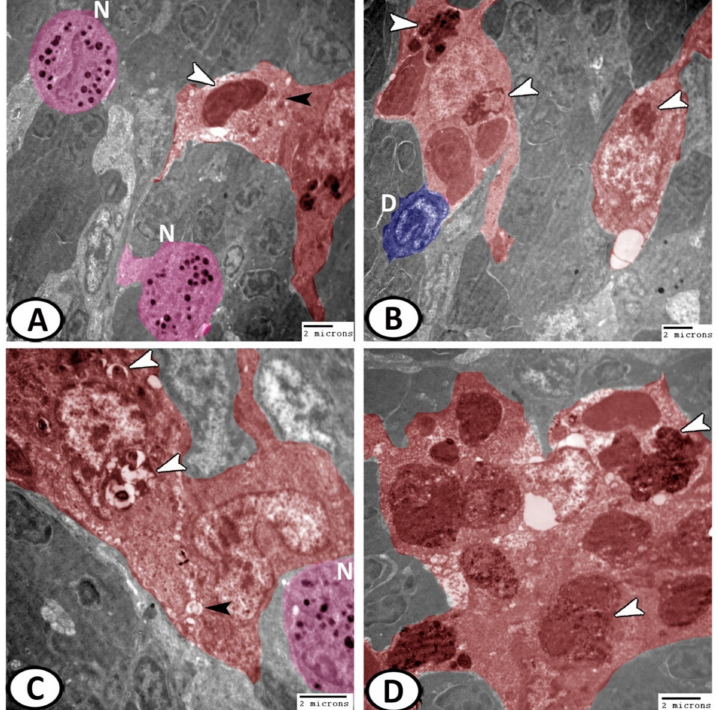
Figure 11. Digital colored TEM of the macrophages in the spleen. ( A , B ) Macrophages (red) dis- played long pseudopodia and their cytoplasm contained many lysosomes (black arrowheads) and other phagocytosed materials (white arrowheads). They were usually associated with dendritic cells (blue, D) and neutrophils (pink, N). ( C ) The active phagocytosing macrophages (red) were characterized by the kidney-shaped nucleus, vacuoles (black arrowheads), and phagocytosed ma- terials (white arrowheads). Note the presence of neutrophils (pink, N). ( D ) They were merged into spherical structures known as melanomacrophage centers (MMCs, red) with vesicles containing pigments